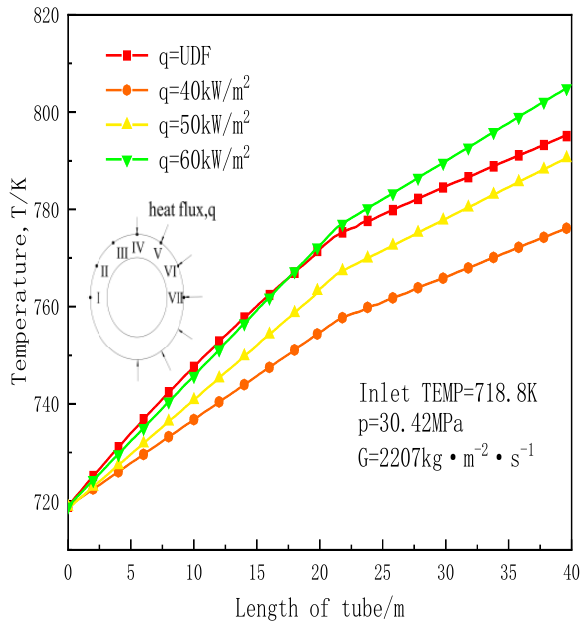
Figure 8. Temperature distribution of the tube length at different heat fluxes ( p = 30.42 MPa, G = 2207 kg/(m 2 · s), q = 39.8~71.2 kw/m 2 ).